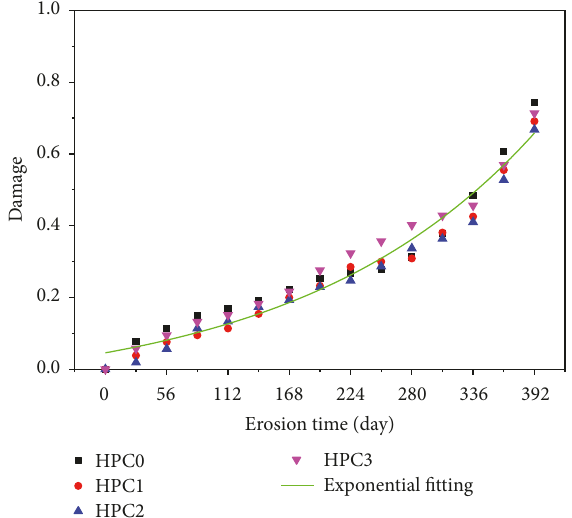
Figure 10: Damage of HPCs at various erosion